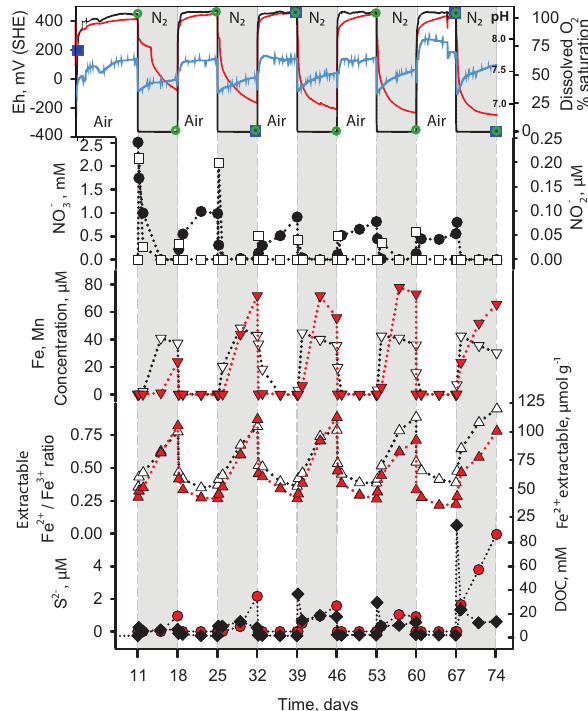
Figure 3. Aqueous chemistry and iron extraction data with time dur- ing reactor experiments: the solid red line is E h , solid black line is DO, solid blue line is pH, full black circles are NO − are NO − , inverted red triangles are Fe (aq) , inverted white triangles 2 are Mn (aq) , red triangles are Fe 2 + 0.5M HCl extractable, white tri- angles are Fe 2 + / Fe 3 + ratio in 0.5M HCl extract, red circles are S − and black diamonds are DOC. Sampling points for 31 P NMR and extracellular enzyme assays (EEA) are shown on the E h curve ( 31 P NMR is indicated by open blue squares and EEA by open green